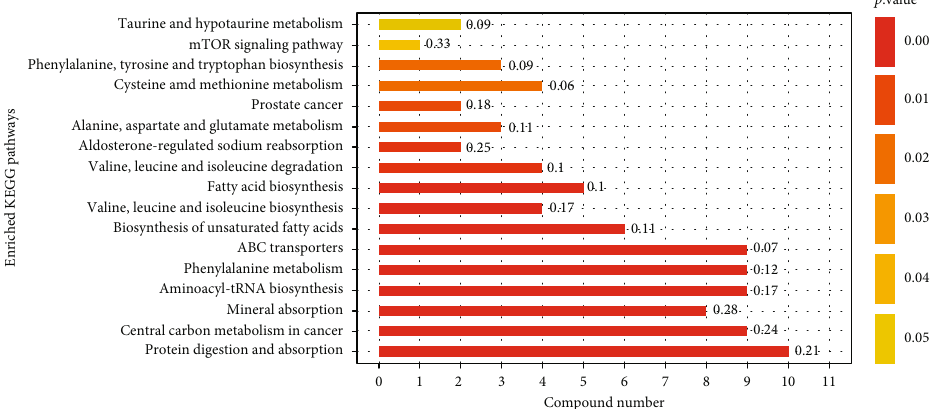
Figure 4: KEGG pathways. Numbers on the right of the bar are rich factor, re fl ecting the degree of enrichment ( rich factor = the number of genes enrichedin this pathway/the number of allgenes in this pathway